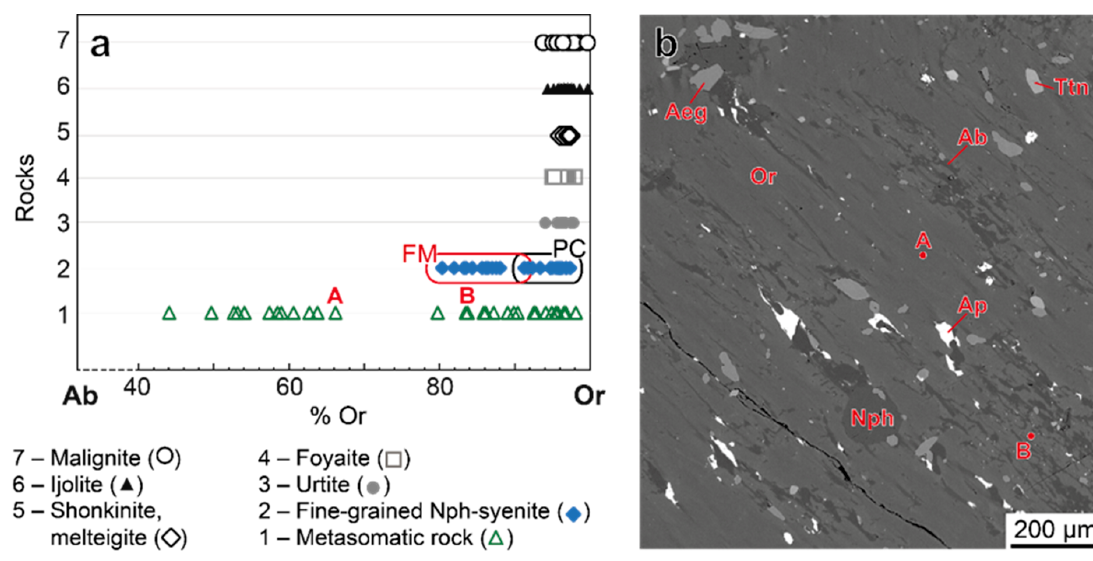
Figure 8. ( а )—The composition of alkali feldspar from the rock of the Alluaiv site in the coordinates of albite (Ab)–orthoclase (Or). In fine-grained nepheline syenite: FM—fine-grained mass; Р C— phenocrysts. In metasomatic rock: A, B–composition of alkali feldspar corresponding to points in Figure 8b. ( b )—fragment of alkali feldspar crystal in metasomatic rock. BSE-image